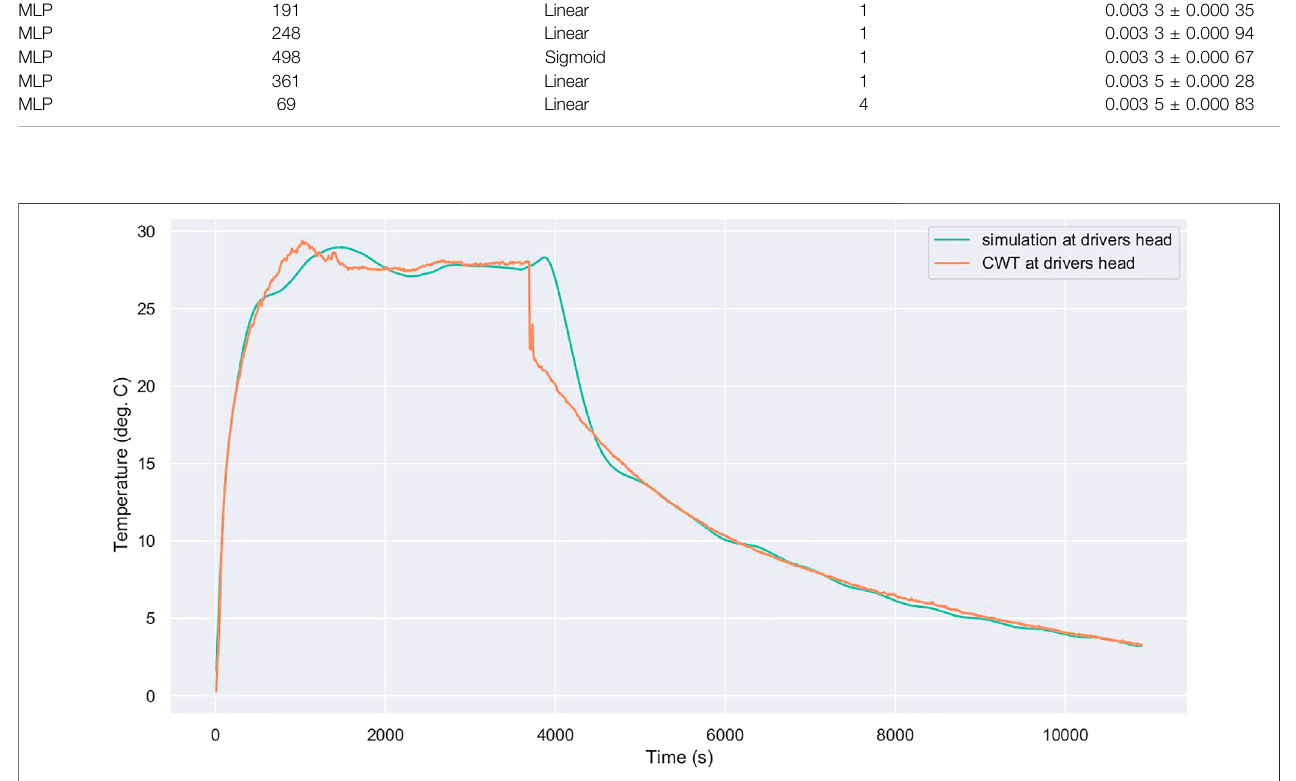
FIGURE5| Comparisonofsimulationproducedcurvefortheairtemperatureatthedriver ’ sheadversusmeasurementdatafromCWT1(withoutsmoothing)giving an RMSE of 0.78. The trial settings are 22 ° C on defrost/ fl oor with fresh distribution at 50 km h − 1 for 60 min, then all settings are switched off for 120 min.